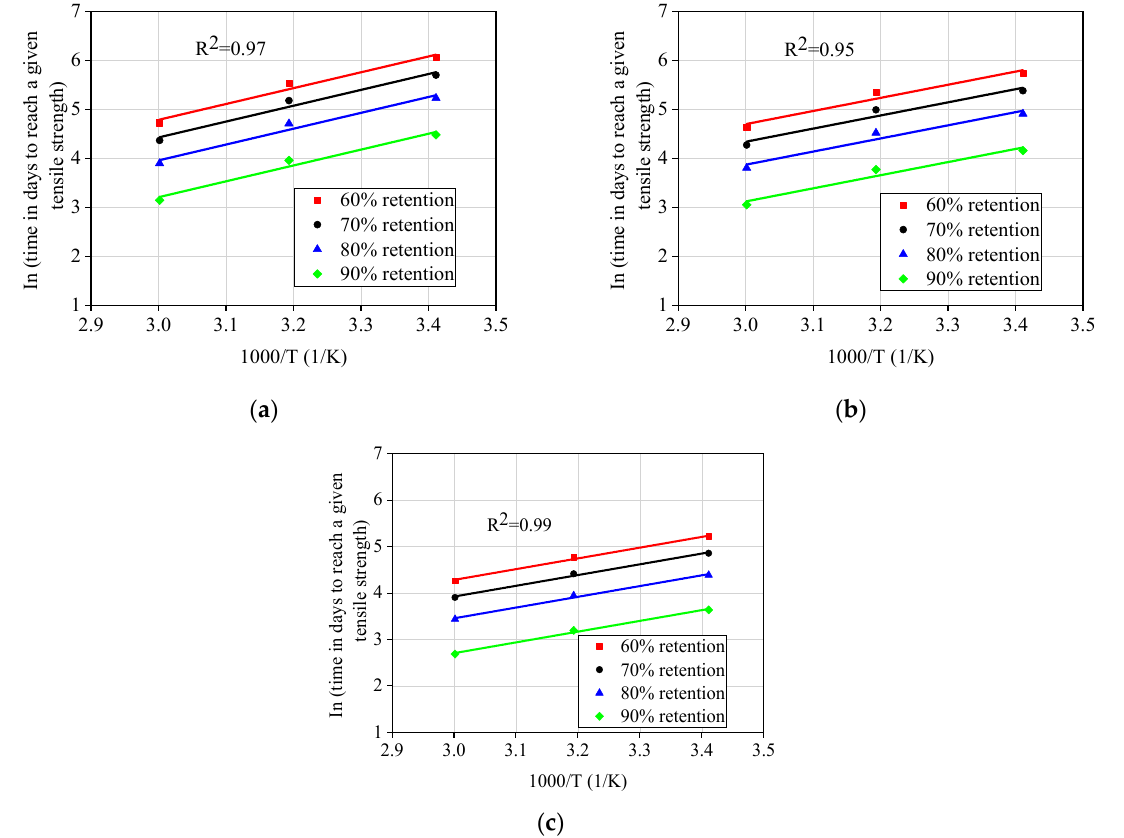
Figure 13. Arrhenius plots of tensile strength degradation: ( a ) 0% stress level, ( b ) 20% stress level, and ( c ) 40% stress level. Table 7. Coefficients of regression equations for Arrhenius plots.